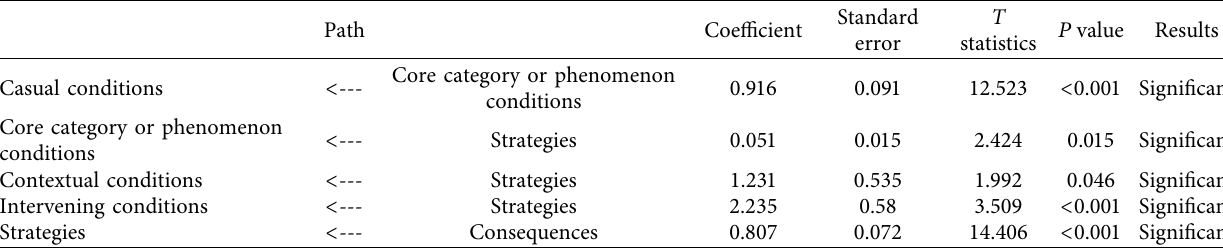
Table 8: Fitting the policy-making pattern model related to biomass energy development training in agriculture to investigate the direct relationships of variables.